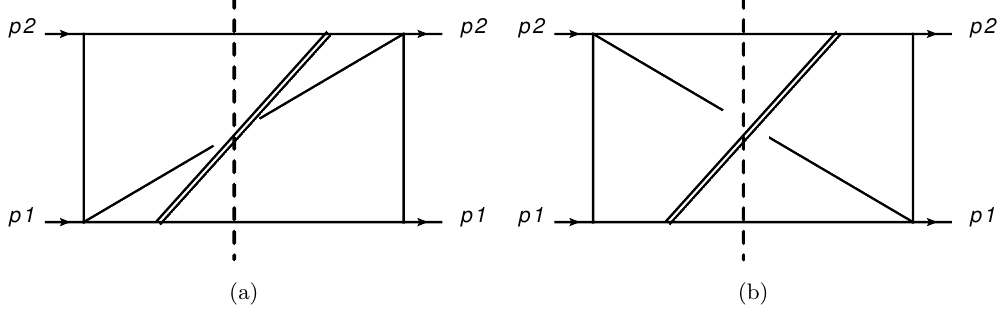
Figure 1 . Phase space integrals contributing to triple real corrections to Higgs boson production at N 3 LO. The computation of these integrals involves elliptic integrals. Solid lines represent Feynman propagators. Solid lines crossed by the dashed line correspond to cut-propagators. The doubled line represents the on-shell constraint of the Higgs